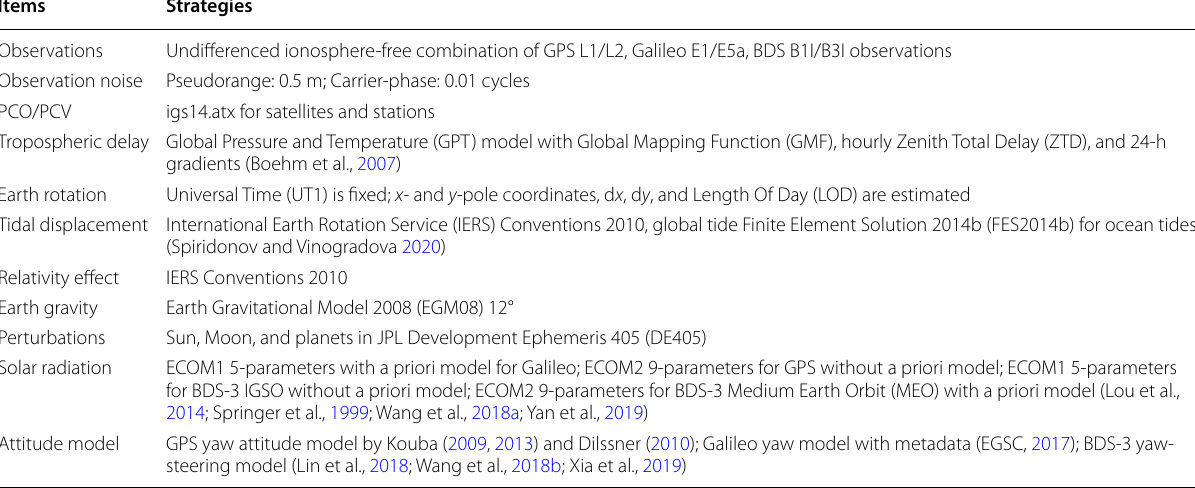
Table 1 Data processing models and strategies